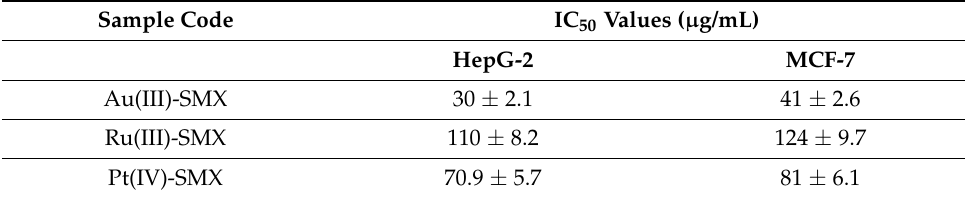
Table 8. Results of Anticancer activity of the prepared complexes.